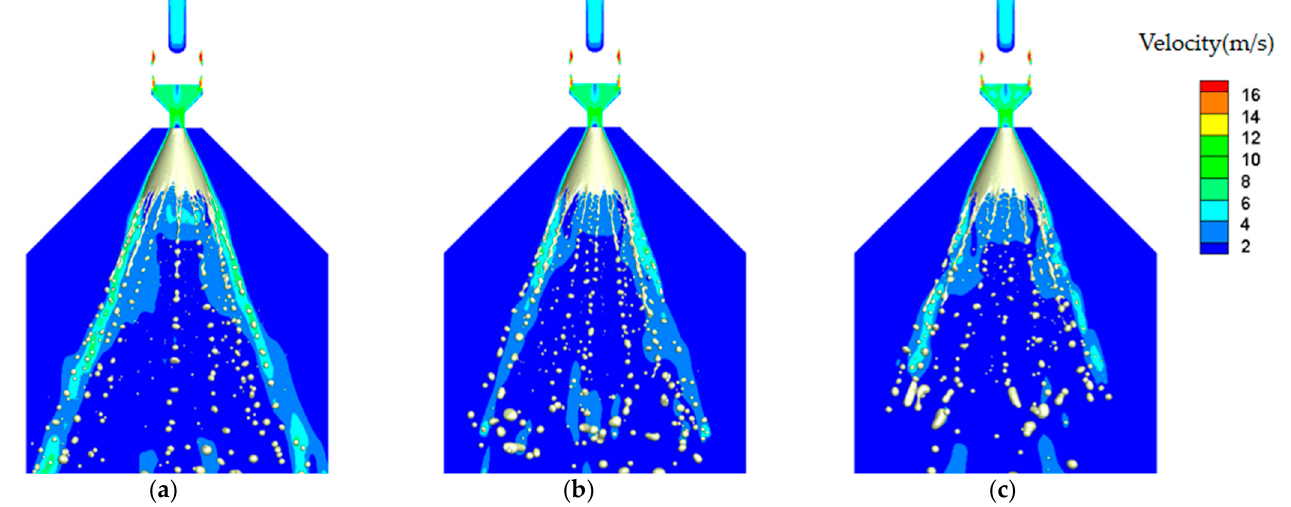
Figure 7. The atomization process and spray field velocity distribution at different temperatures: ( a ) 0 °C, ( b ) − 20 °C, ( c ) − 40 °C.